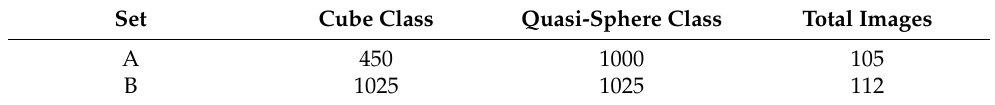
Table 2. Distribution of object classes in the selected training datasets. Cube Class Quasi-Sphere Class Total Images A 450 1000 105 B 1025 1025 112